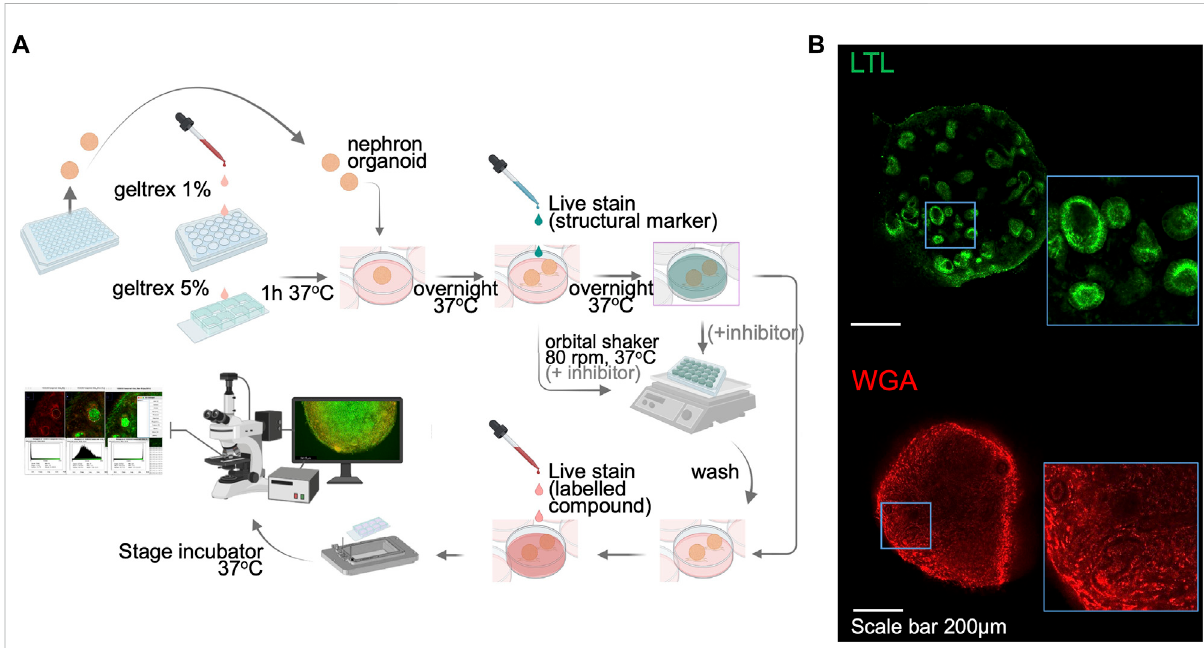
FIGURE 2 Sample preparation and setup for kidney organoid functional assays by live imaging. (A) A schematic illustration of the live imaging protocol. Following theorganoid attachmenton culture plate/chamber slides, structural markers were utilizedto helpdistinguish nephron segmentation.The orbital shaker allows the live staining dyes to penetrate into the kidney organoid. The stage-top incubator maintains the culture environment of live organoidsandenablesreal-timefunctionalassay. (B) Immuno fl uorescentimagesofliveLTLandWGAstaininginkidneyorganoids.WGA,wheat germ